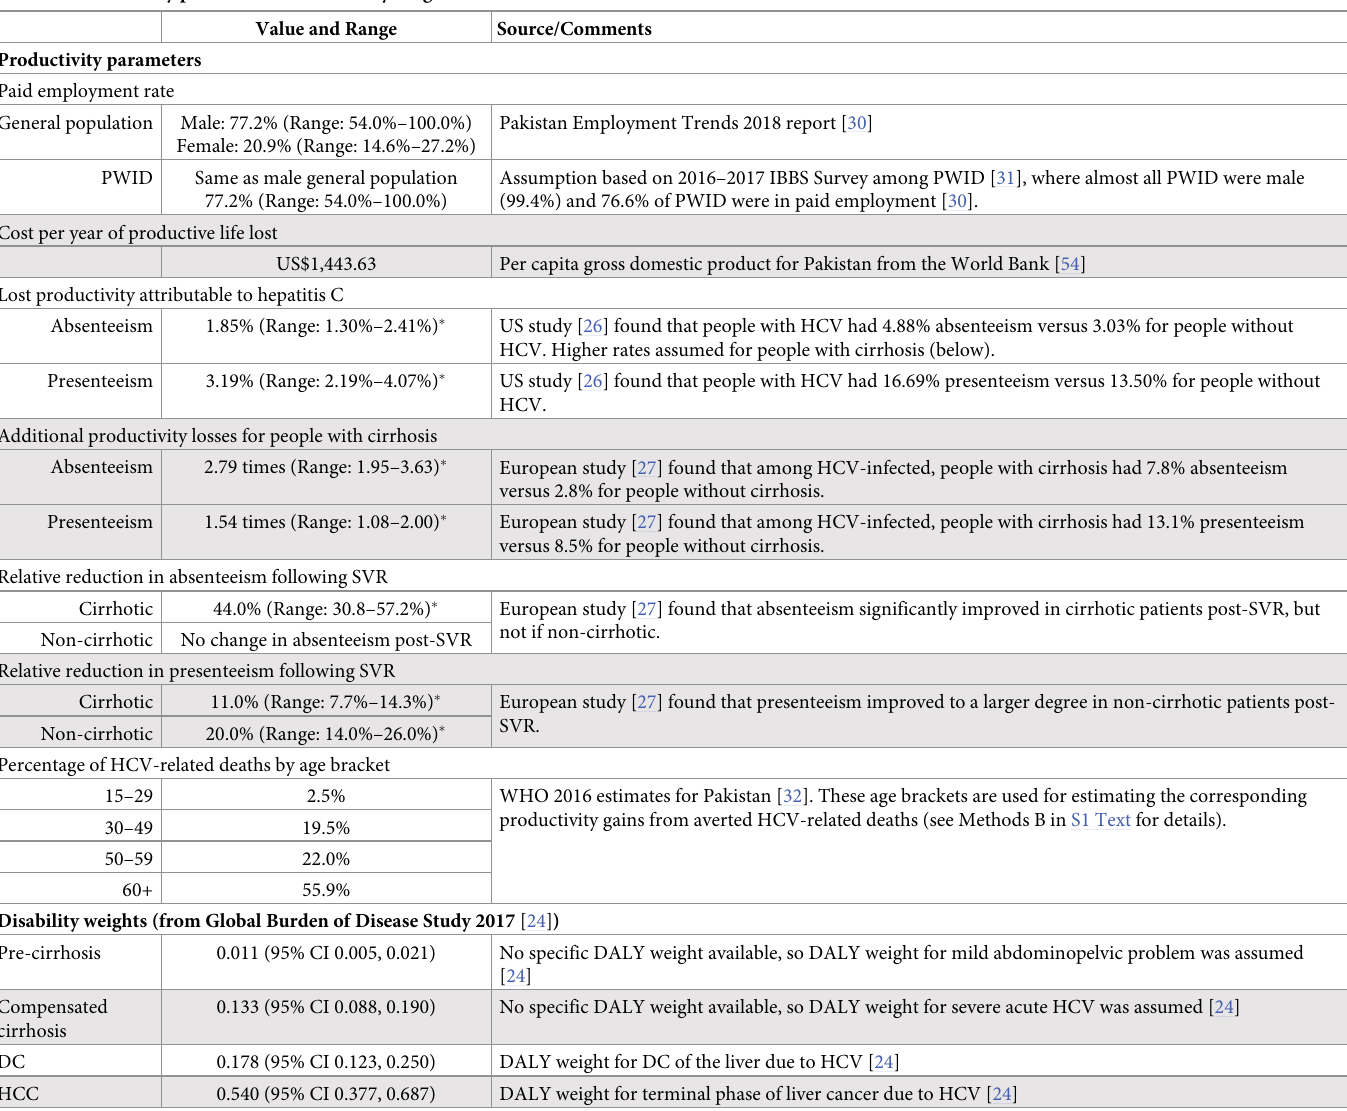
Table 2. Productivity parameters and disability weights used in the